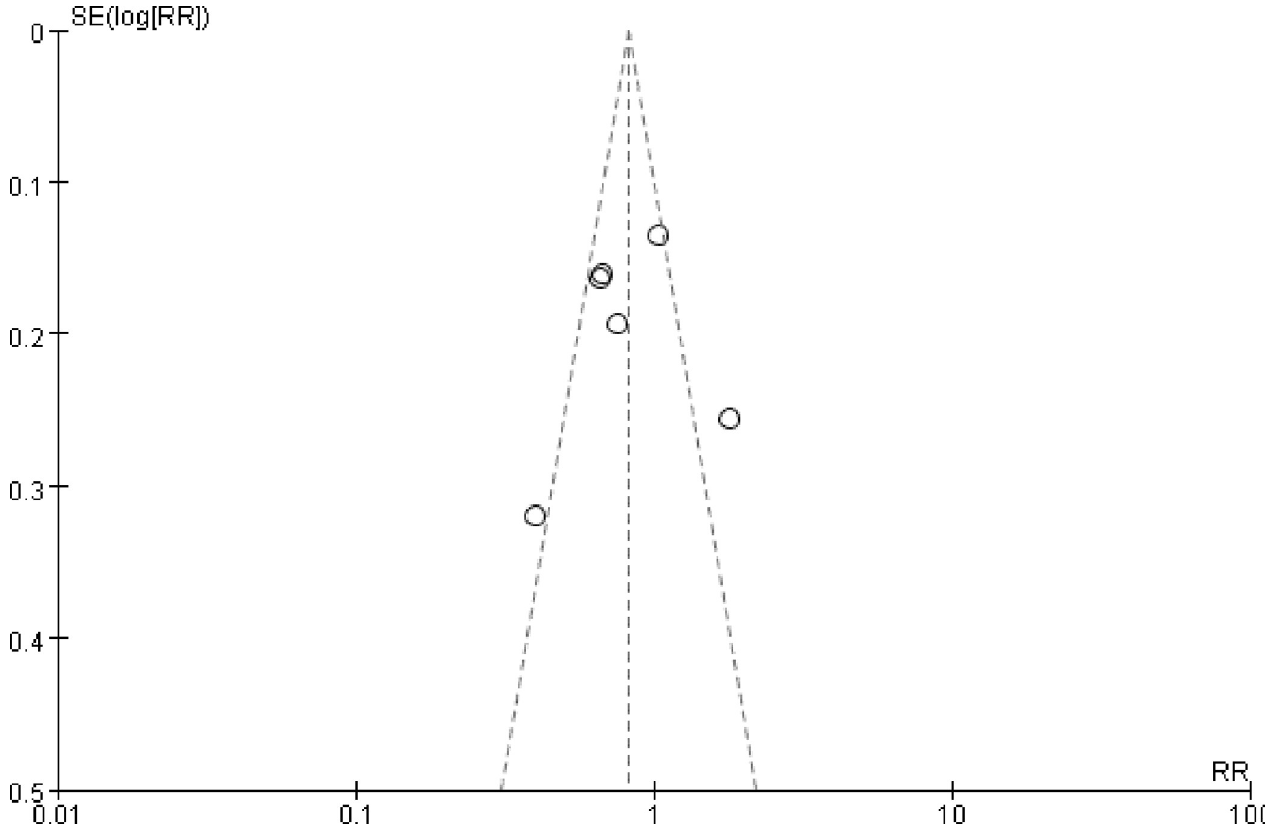
Fig 6. Funnel plot to assess for evidence of publication bias. Oblique line represented the pseudo 95% confidence interval. Circles represented the included studies.